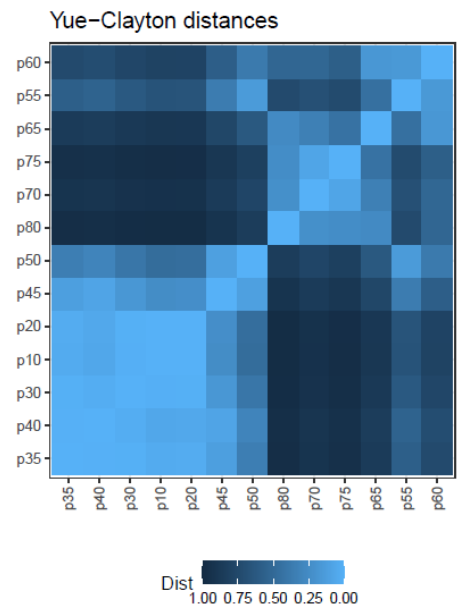
Figure 9. Matrix of Yue–Clayton distances between quasispecies haplotype